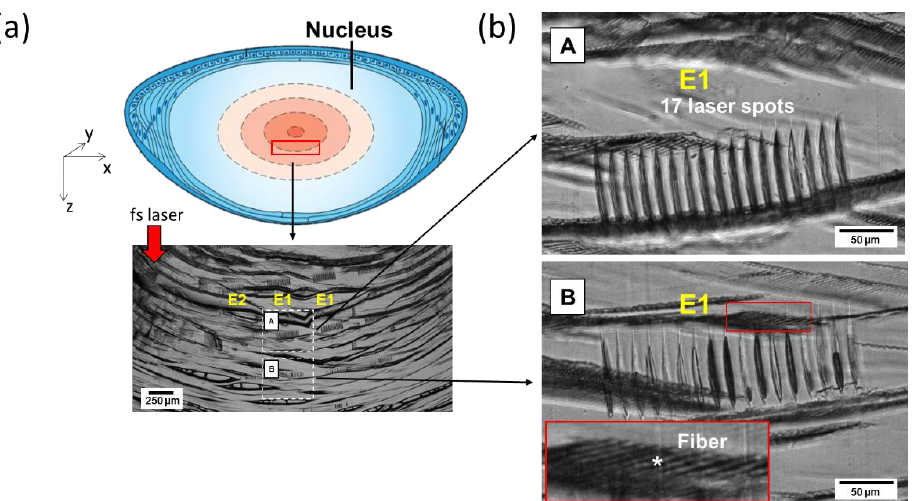
Figure 4. Microscopic images of 60 μm thick histological slices of typical laser-irradiated zones. ( a ) Scheme of the observed area within the lens with an overview of the various laser-impacted zones’ cross sections. ( b ) Magnified view of two zones of interest (A and B) exposed to the same laser-pulse energy and at a similar X–Y position within the lens but at different Zs. Wherever the irradiation sites are clearly observable and well contrasted, the fiber network (*) appears relatively unaffected.